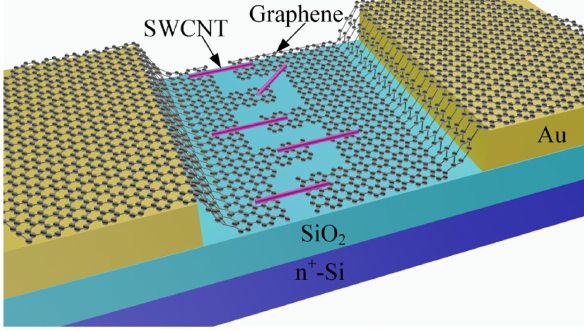
Figure 7. Schematic of the SWCNT-graphene FET.